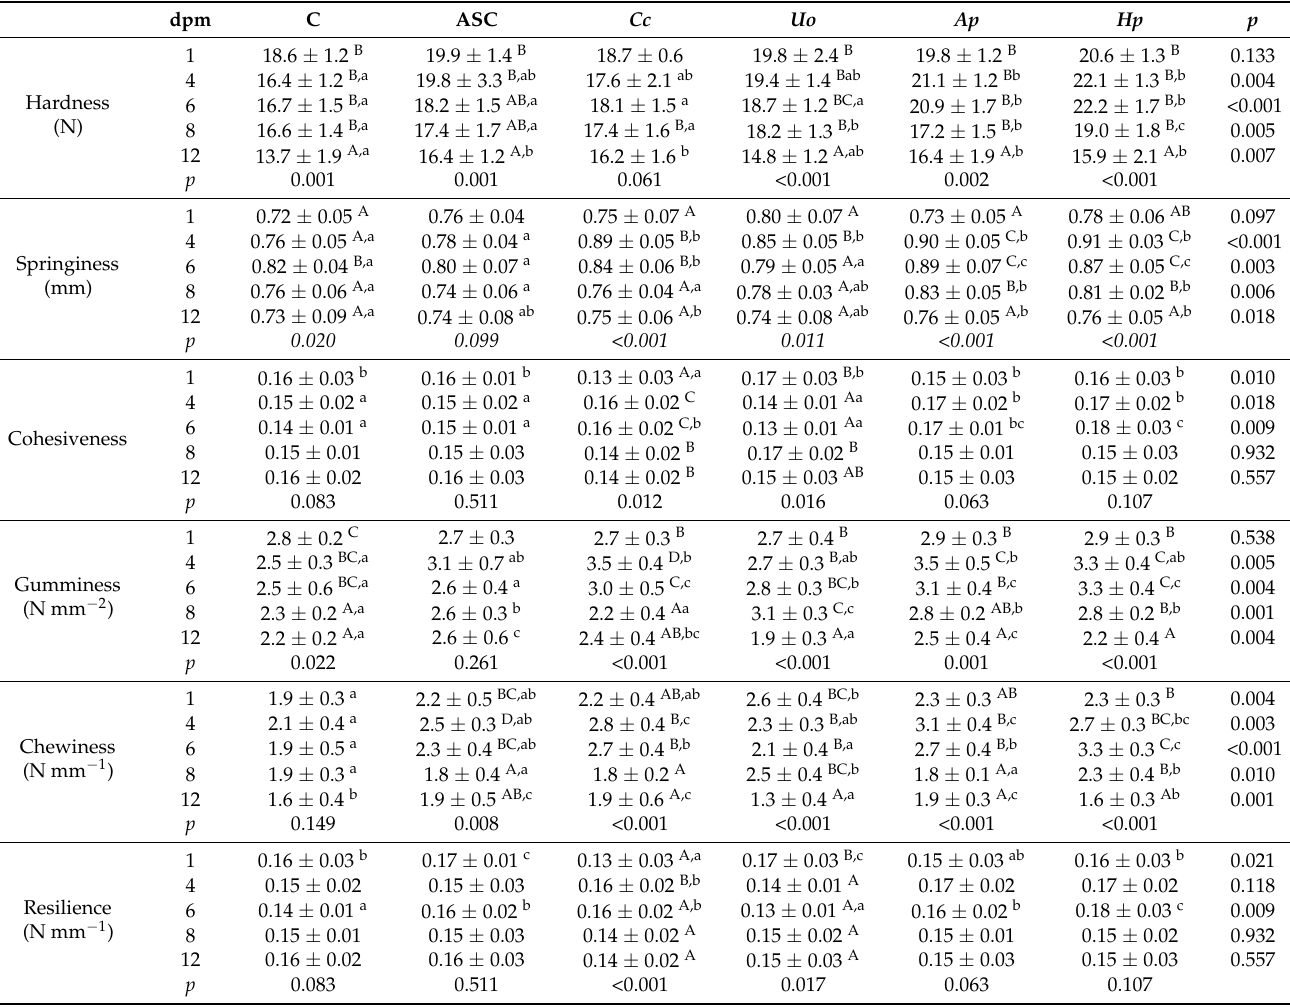
Table 3. Changes in texture profile analysis parameters of rainbow trout fillets treated with algae aqueous extracts throughout a 12-day cold storage (4 ◦ C)